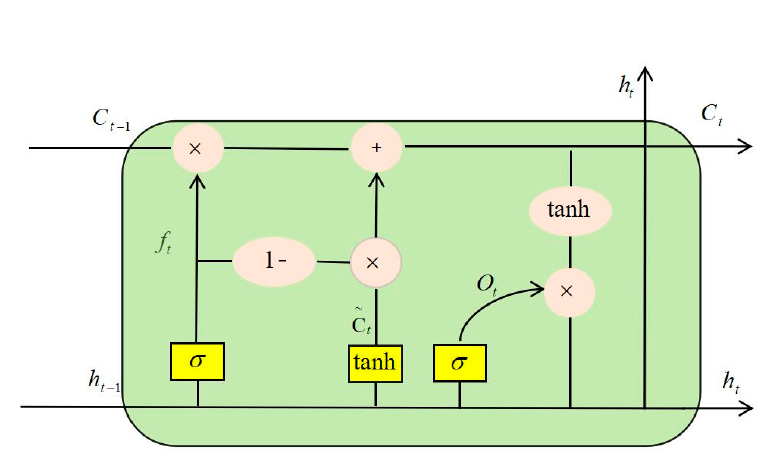
Figure 14. Improved LSTM network structure.